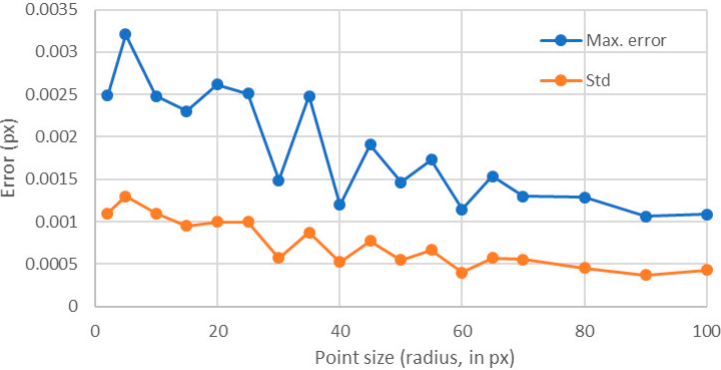
Figure 11. Influence of the point size for 256 intensity levels.